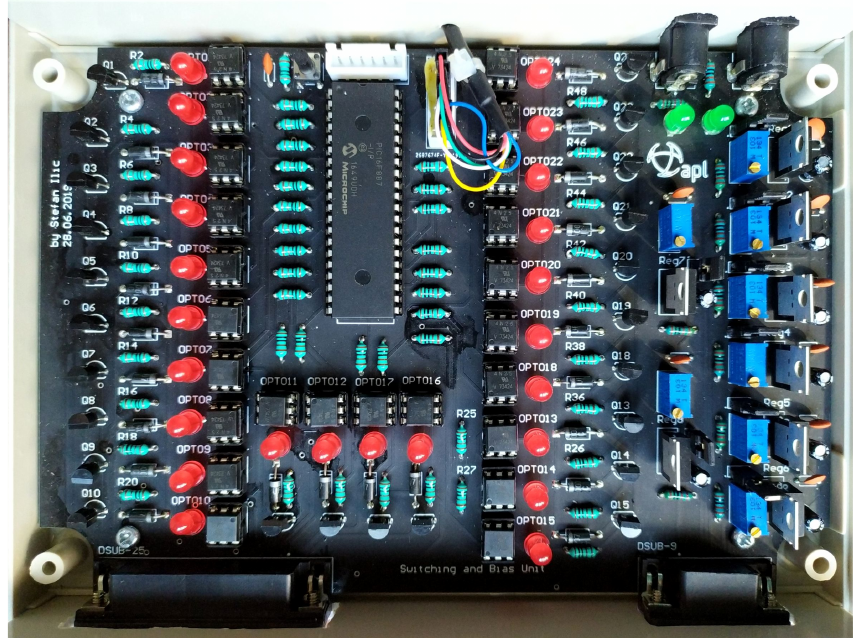
Figure A3. Switching And Bias Unit.